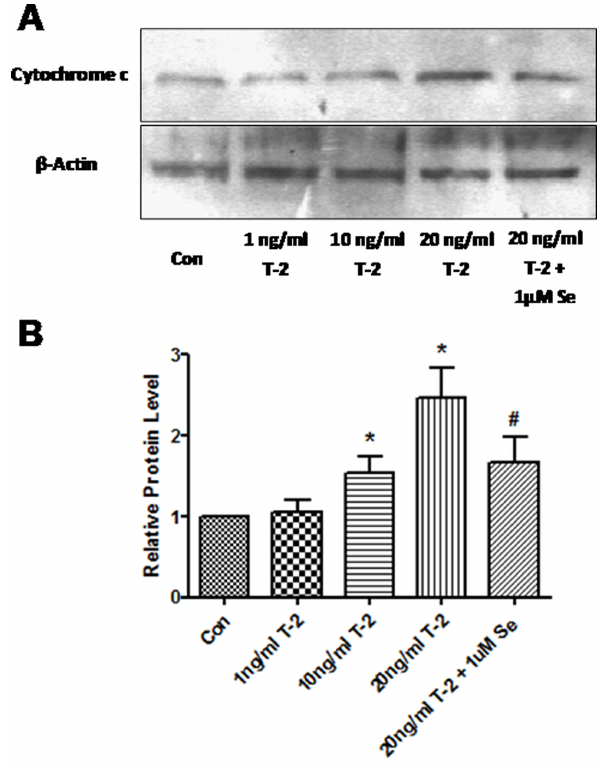
Figure 4. Western blot analysis for cytochrome c protein in normal human chondrocytes after treatment with 1, 10, 20 ng/ ml T-2 toxin and 1 uM Na 2 SeO 3 + 20 ng/ml T-2 toxin for 5 d. A. Western blot of cytochrome c. B. Increase of cytochrome c relative to control. Data are shown as the mean 6 S.D. of at least three separate experiments. * P , 0.01 vs. control; # P , 0.01 vs. 20 ng/ml T-2 toxin group.